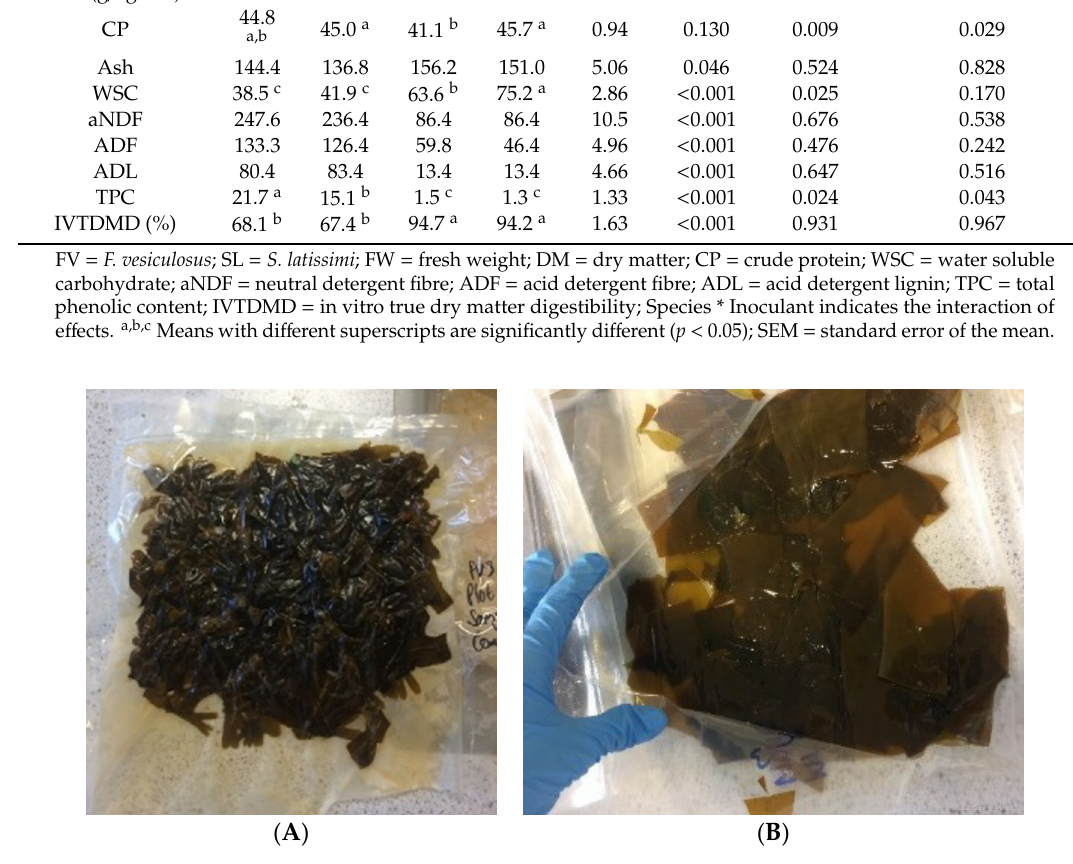
Table 1. Chemical composition and IVTDMD of the seaweed silages, treated with (FVi, SLi) and without (FVu, SLu) a Lactobacillus plantarum inoculant, after 90 days ( n = 3) (g / kg DM unless stated otherwise). Chemical Profile